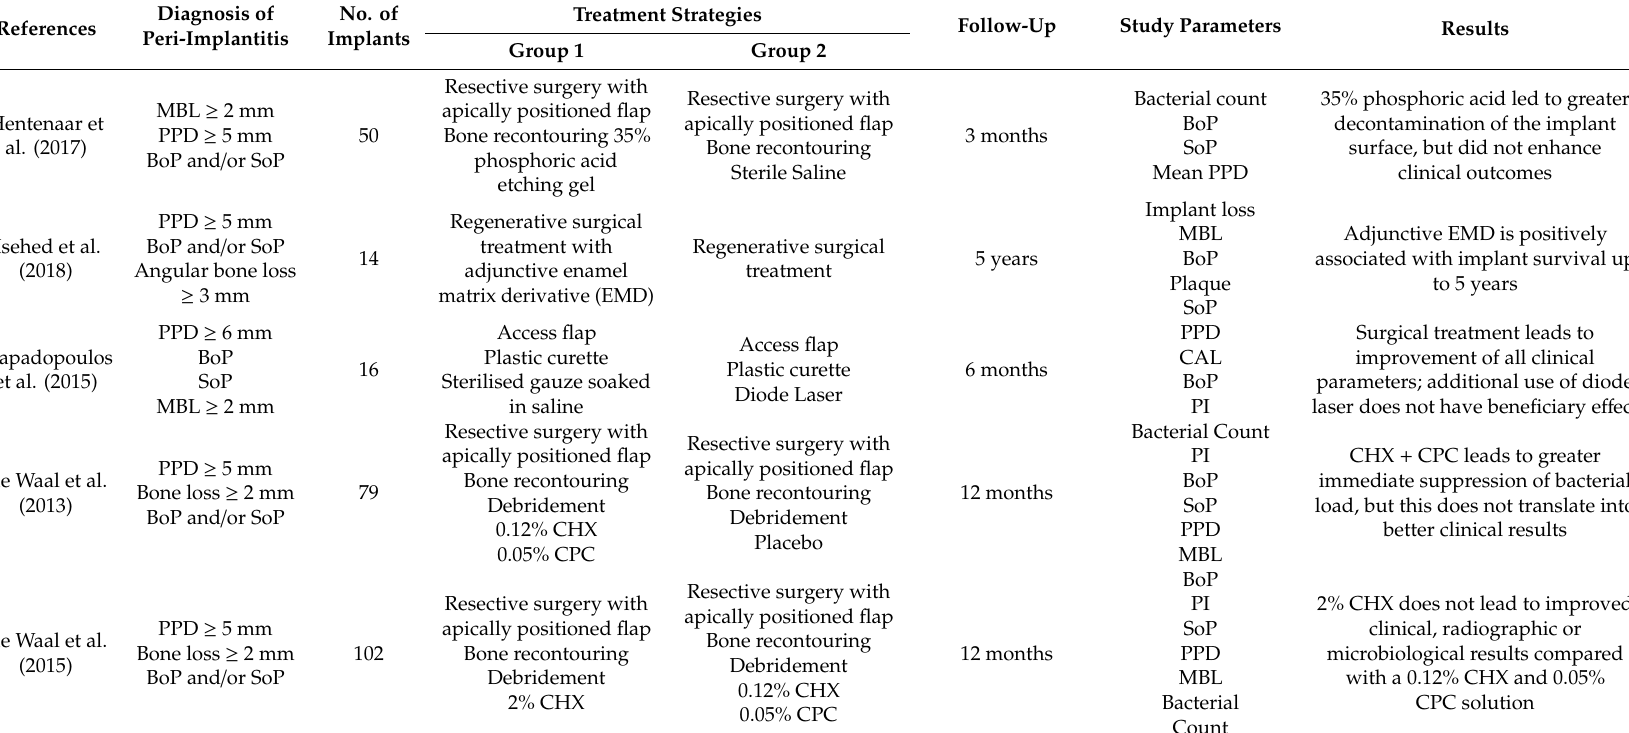
Table 7. Summary of surgical